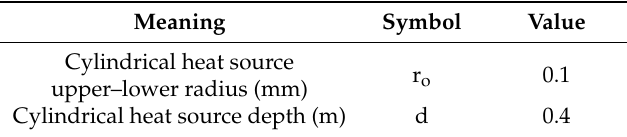
Table 6. Cylindrical heat source parameter.